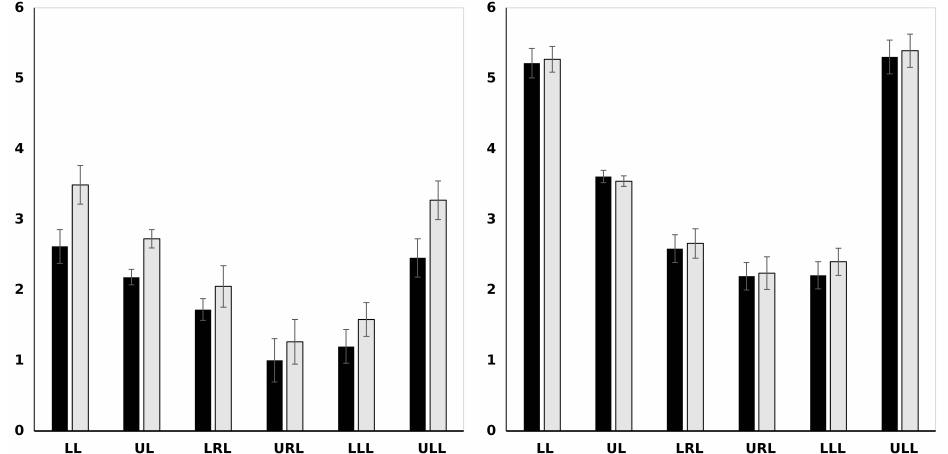
Figure 8. Lesion contrast-to-noise ratio (CNR) for the six lesions for MC-OSSPS and R-MC-OSSPS. Left: without post-smoothing; right: with 6 mm Gaussian post-smoothing. Solid and hollow bars show the mean values for noisy data (10 noise realizations) of MC-OSSPS and R-MC-OSSPS, respec- tively. The error bars denote the standard deviation of the percentage bias values over the 10 noise realizations. The lesions are lower liver (LL), upper liver (UL), lower right lung (LRL), upper right lung (URL), lower left lung (LLL), and upper left lung